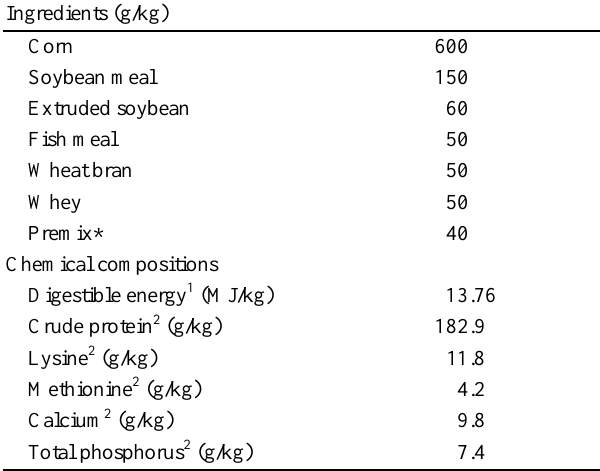
Table 1. Ingredient and composition of the basal diet